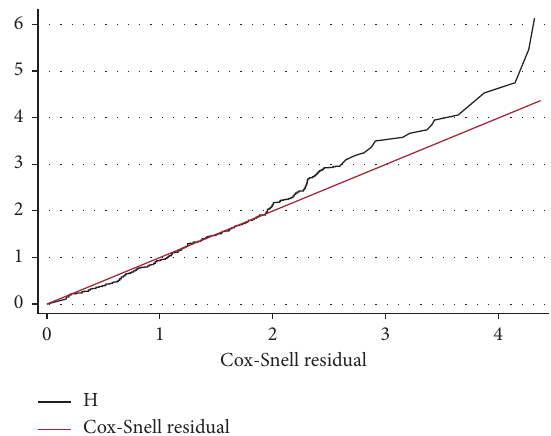
Figure 3: Cox Snell residual test for overall adequacy of the